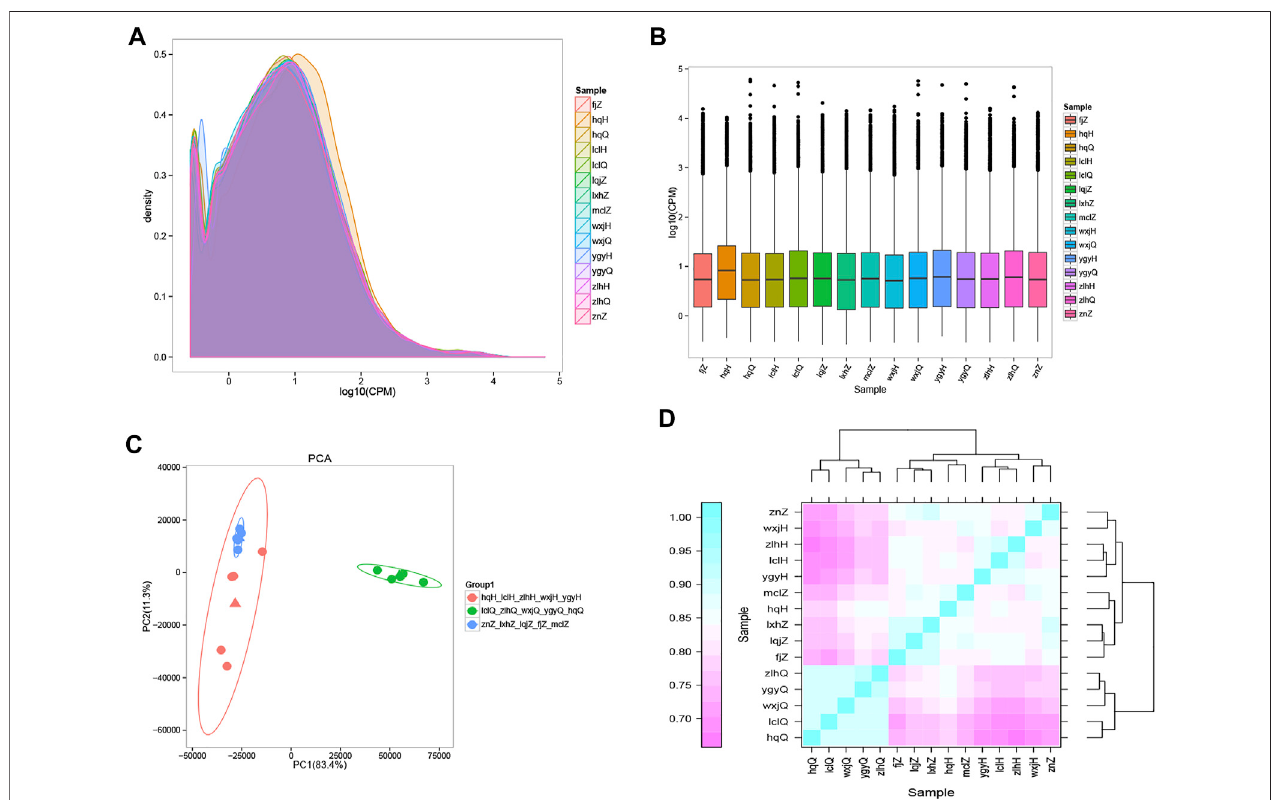
FIGURE2| GeneexpressiondistributionThedifferentcoloursinthecontrastmapofthegeneCPMdensitydistributionofeachsamplerepresentdifferentsamples, theabscissarepresentsthelogarithmoftheCPMofthecorrespondingsample,andtheordinaterepresentstheprobabilitydensity. (A) TheabscissaintheCPMboxplot representsthesample,and theordinate represents thelogarithmofthesampleexpression CPM.The fi gure showstheexpression levelofeach samplefrom thepointof view of the overall discreteness of the expression quantity. (B) PCA map drawn according to the gene expression (CPM) of each sample. Each point represents a sample, each colour represents a sample group, and the ellipse represents the con fi dence interval of the grouped sample. Orange: psoriasis patients after treatment; green: psoriasis patients before treatment; blue: normal controls. (C) Heatmap of the expression correlations in pairs of samples. The abscissa represents the sample, and the ordinate represents the Spearman correlation coef fi cient r, which was used to evaluate the correlations of biological replicates. (D) The expression quantity correlationheatmapofpairwisesamples:theAbscissarepresentsdifferentsamples;theSpelmancorrelationcoef fi cientr(Spearman ’ sCorrelationCoef fi cient)isusedas the evaluation index of biological repetition correlation, which is expressed by